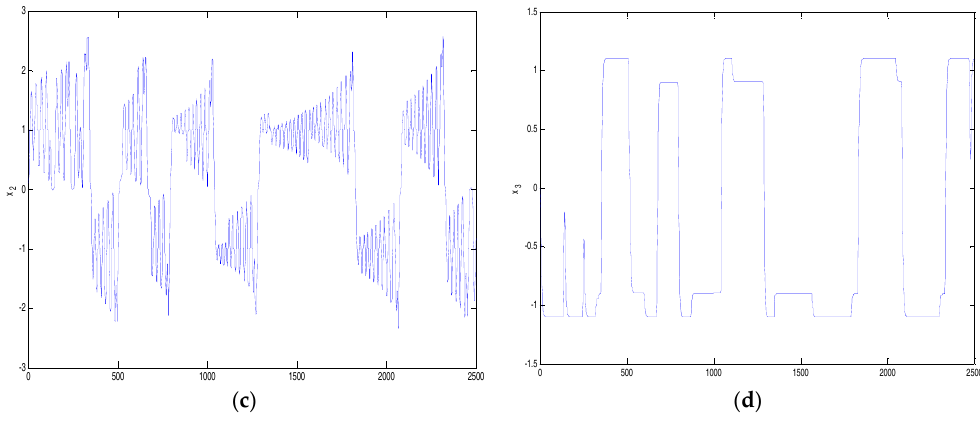
Figure 9. Numerical results of the x 2 ‐ x 3 direction 2 ‐ D multi ‐ scroll attractors ‐ II: ( a ) 4 ‐ double scrollin x 1 ‐ x 2 ‐ x 3 plane; ( b ) variable x 1 (t); ( c ) variable x 2 (t); and ( d ) variable x 3 (t).